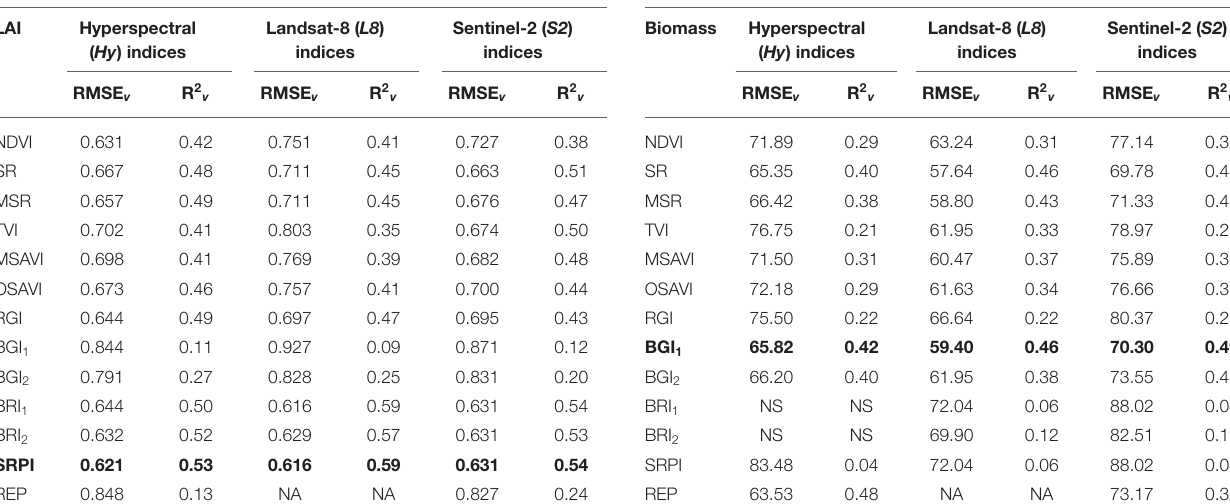
TABLE 7 | Validation statistics (RMSE v and R 2 v ) of simple linear regression models of Hyperspectral ( Hy ) indices, and synthesized Landsat-8 ( L8 ) and Sentinel-2 ( S2 ) indices obtained for leaf area index (LAI) of finger millet.